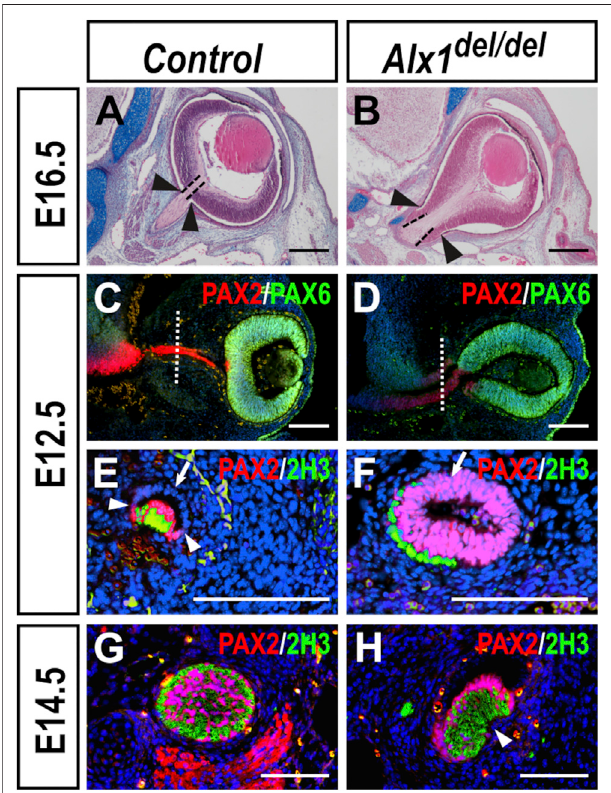
FIGURE 6 | Ocular developmental defects in Alx1 del/del embryos. (A, B) Frontal sections of control (A) and Alx1 del/del (B) embryo heads at E16.5. Dashed lines in (A, B) mark the exit of the optic nerve from the optic cup, whereas arrowheads point to the proximal boundary of the retinal pigment epithelium. (C, D) Immuno fl uorescent detection of PAX2 (red) and PAX6(green)infrontalsectionsofcontrol (C) and Alx1 del/del (D) embryoheads at E12.5. White dotted lines in (C, D) indicate the corresponding plane of sagittal sections shown in Panels (E, F) , respectively. (E – H) Immuno fl uorescent detection of PAX2 (red) and neuro fi lament in the retinal ganglion axons recognized by the 2H3monoclonal antibody (green) in sagittal sections throughthemiddleofopticstalkincontrol (E,G) and Alx1 del/del (F,H) embryosatE12.5 (E,F) andE14.5 (G,H) .Whitearrowheadsin (E) pointtothe boundaryofPAX2 expression in theventral regionoftheoptic stalkepithelium in the control embryo whereas the white arrows in (E, F) point to the dorsal region of the optic stalk epithelium. Note that both the PAX2-positive ventral region and the PAX2-negative dorsal/outer layer of the optic epithelium in the E12.5 control embryo (E) is 1-2 cell thick and the bilayered optic stalk epithelium wraps around the retinal ganglion axons (green), with the ventral optic fi ssure still open. In contrast, the optic stalk epithelium in the E12.5 Alx1 del/del embryo (F) is 4-6-cell thick and failed to wrap around the retinal ganglion axons (green). White arrowhead in (H) points failure of optic fi ssure closure in the E14.5 Alx1 del/del embryo. Scale bars in (A, B) and (C – H) are 400 and 200 μ m, respectively. were marked by expression of PAX6 and PAX2, respectively, in